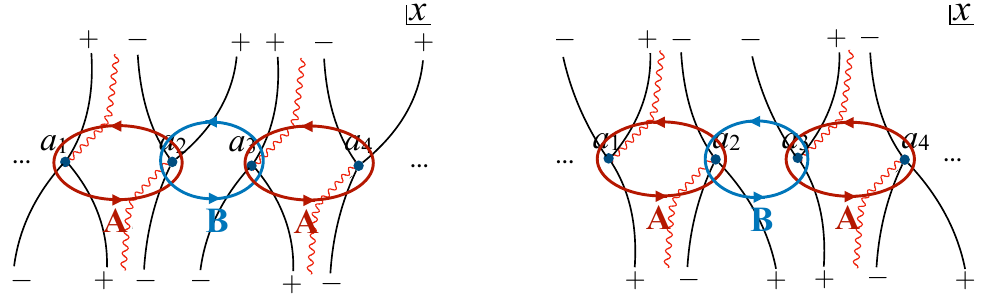
Figure 2 . The Stokes curve for the two periods of the potential 1 − cos( x ) for Im( ~ ) > 0 and Im( ~ ) < 0 , respectively. We also depict the branch cut, the turning points and the path corresponding to the single period.